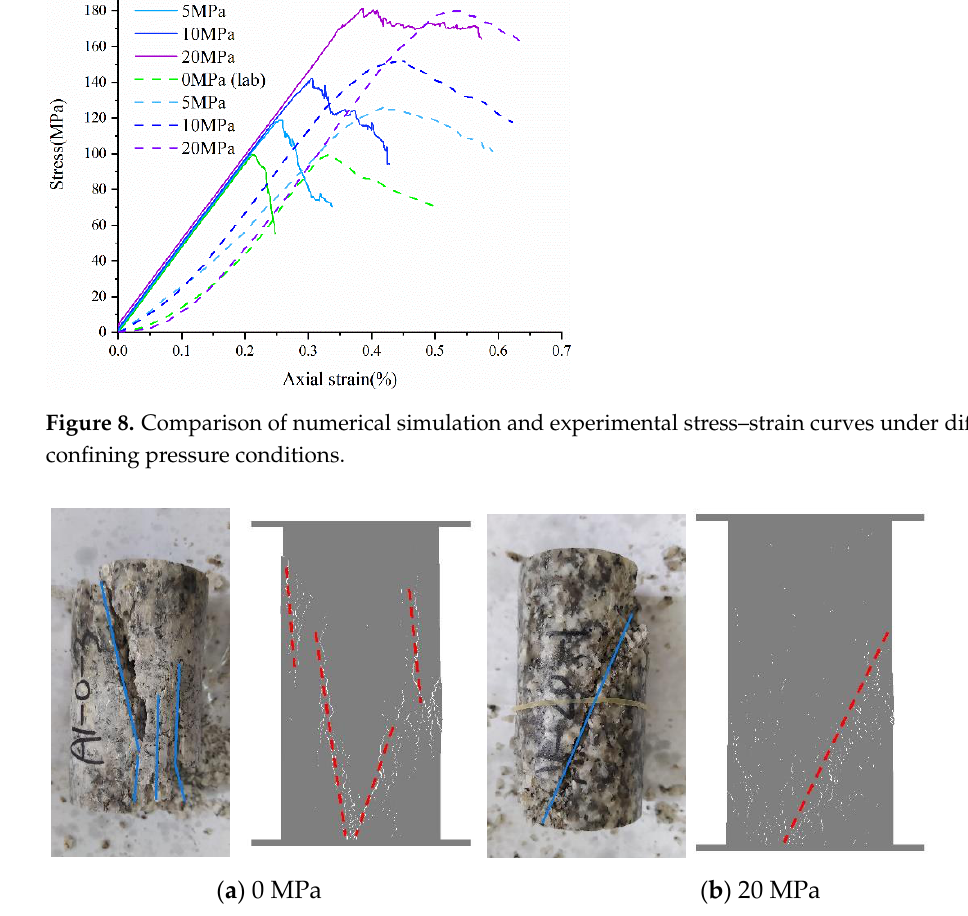
Figure 9. Comparison of the failure mode between the laboratory tests and the simulated ones. ( a )